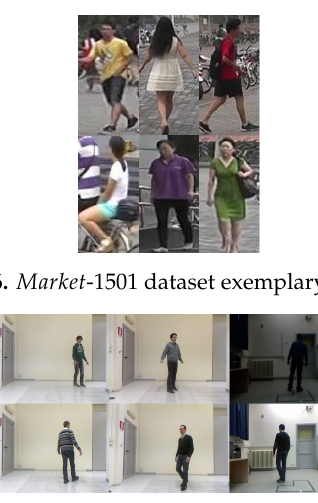
Figure 7. RGBD - ID dataset exemplary